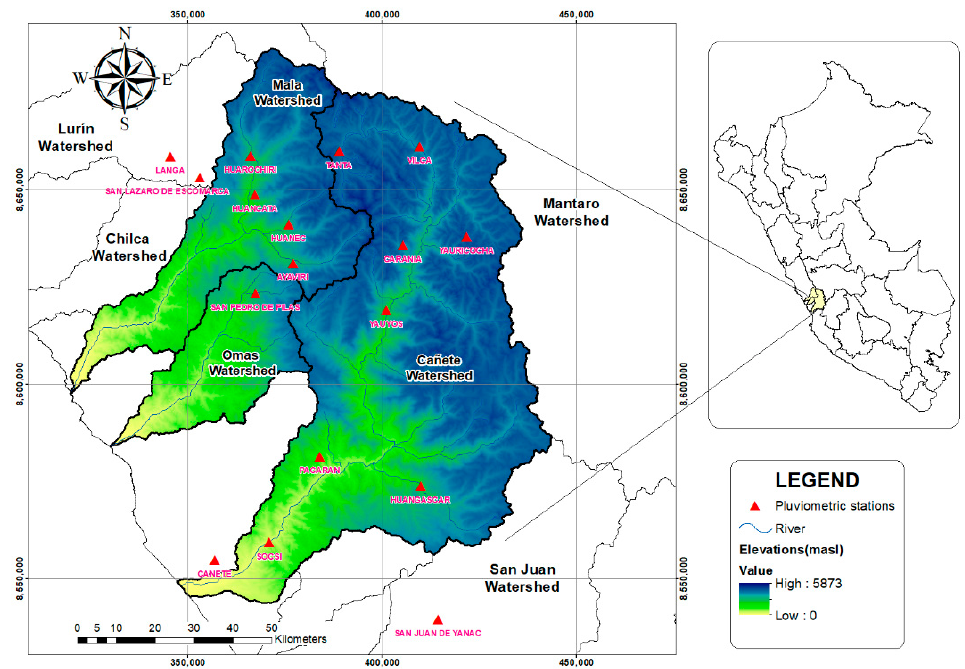
Figure 1. Elevation of the study area, main rivers, selected watershed boundaries, and location of rainfall stations.